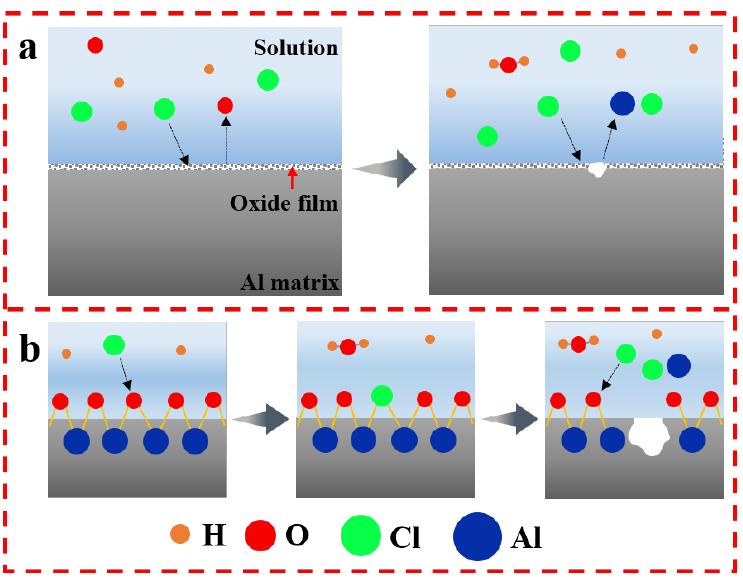
Figure 4. The schematic diagram ( a ) and mechanism diagram ( b ) of the Al alloy pitting corrosion. Figure 5 is the macroscopic morphologies of the alloys immersed in different concen-